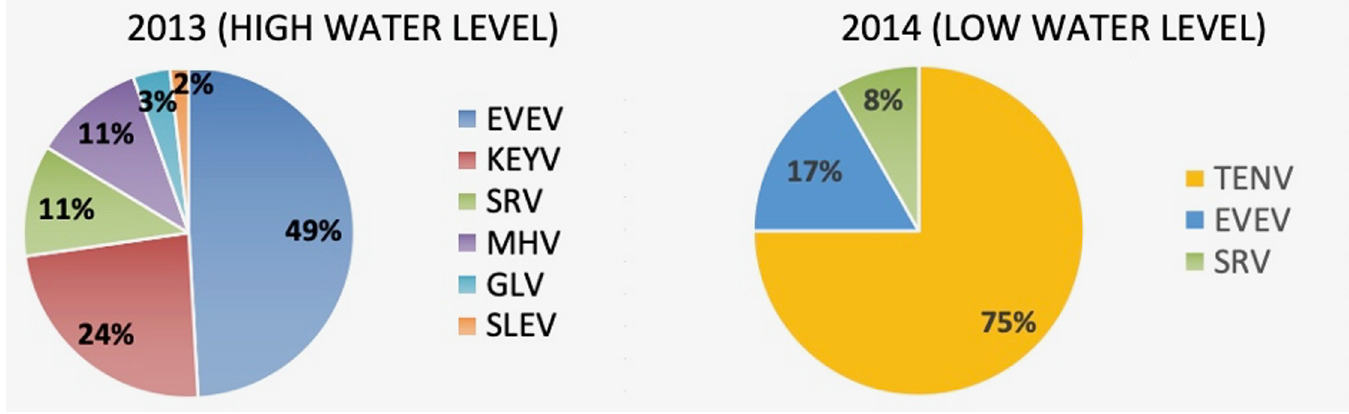
PLOS ONE | https://doi.org/10.1371/journal.pone.0259419 November22, 2021 10 /